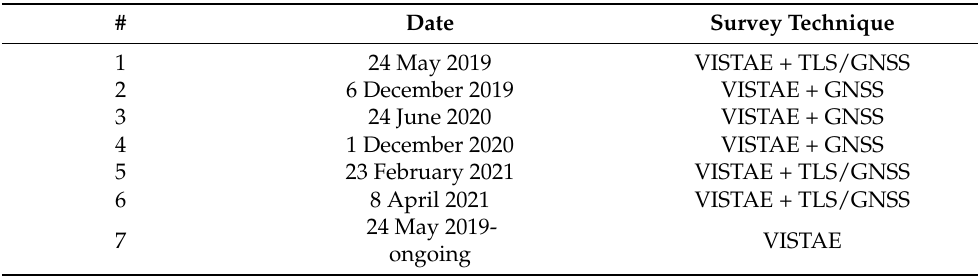
Table 1. List of surveys and specific techniques employed: The low-cost VISTAE (Video monitoring Intelligent Station for Environmental applications); TLS (Terrestrial Laser Scanner); GNSS (Global Navigation Satellite